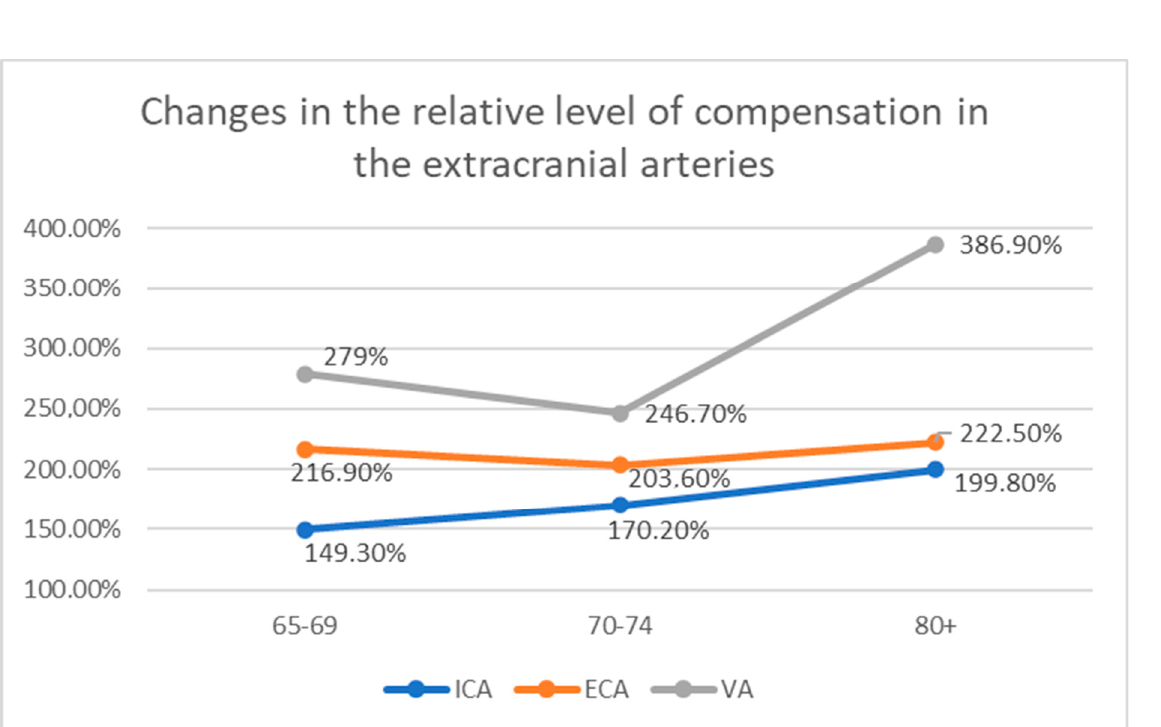
Figure 2. Changes in the relative level of compensation in extracranial arteries in patients with ICA occlusion. The relative level of compensation rises in ICA and VA with increasing age, while in ECA it remains almost unchanged.